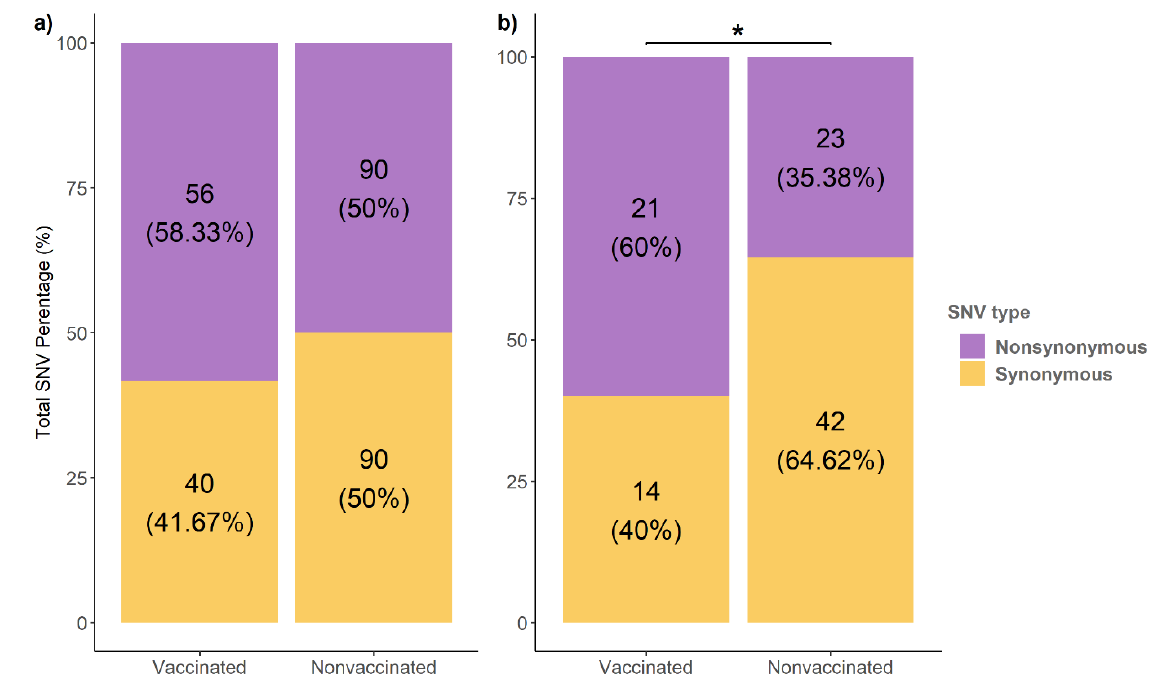
Figure 3. Total number of synonymous and nonsynonymous SNVs found from vaccinated and nonvaccinated animals. ( a ) Substitutions with an allele frequency greater than 1%. ( b ) Substitutions with an allele frequency greater than 5%. * p < 0.05.